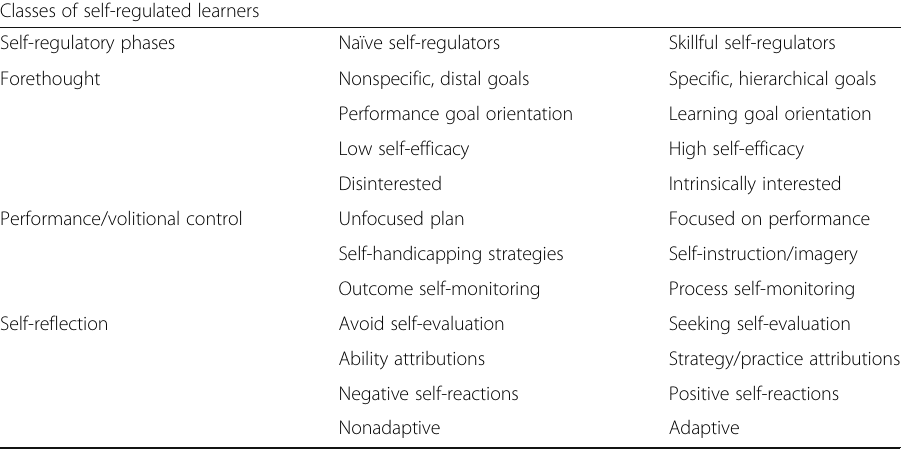
Table 1 Differences between naïve and skillful SRLs (Schunk and Zimmerman 1998) Classes of self-regulated